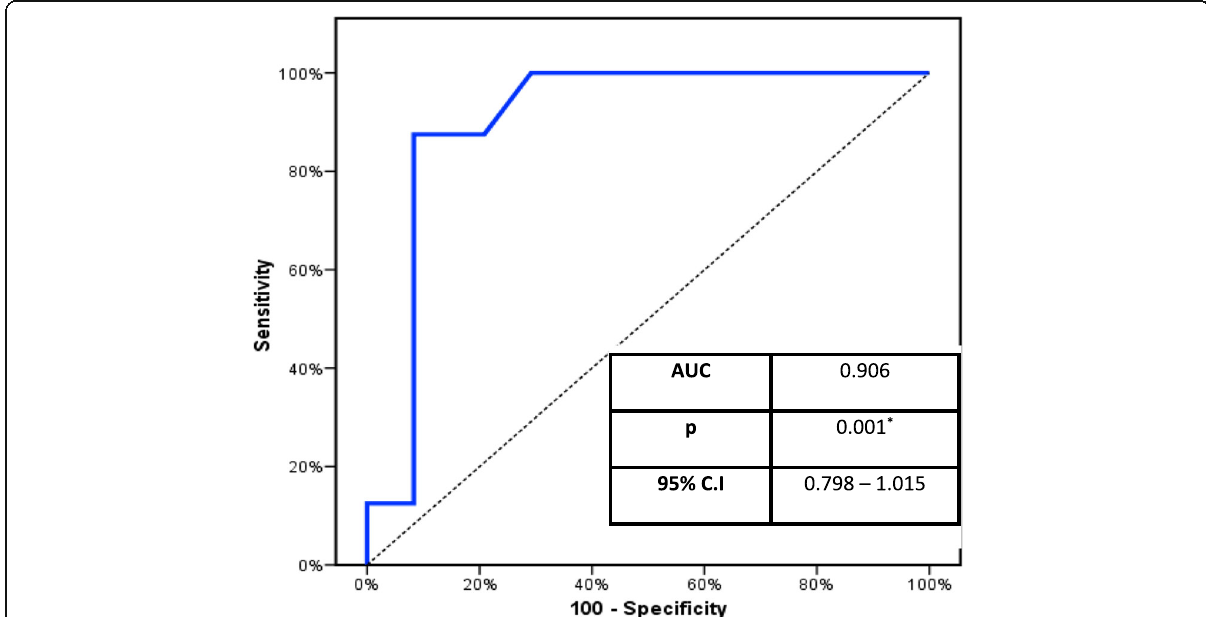
Fig. 7 Receiver operating characteristic curve for prediction of preeclampsia and/or growth restriction and abnormal Doppler. The cutoff values for predicting preeclampsia and the area under the curve were 1.35 m/s and 0.906,